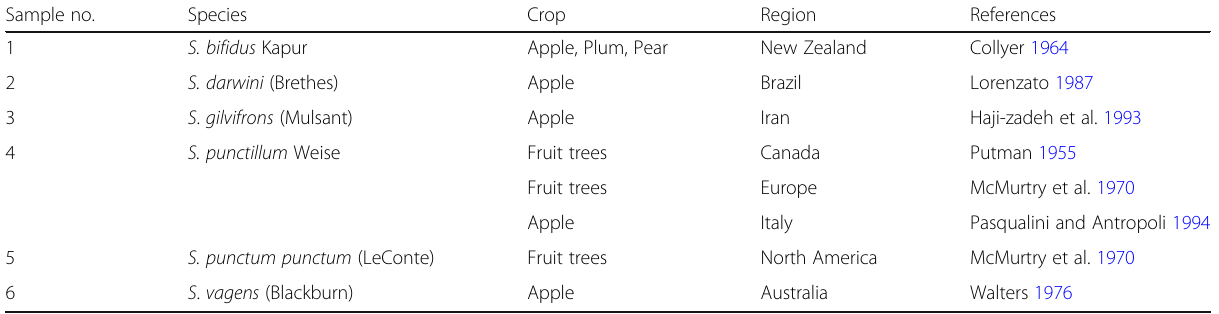
Table 1 Stethorus predators of Panonychus ulmi of the world Sample no.